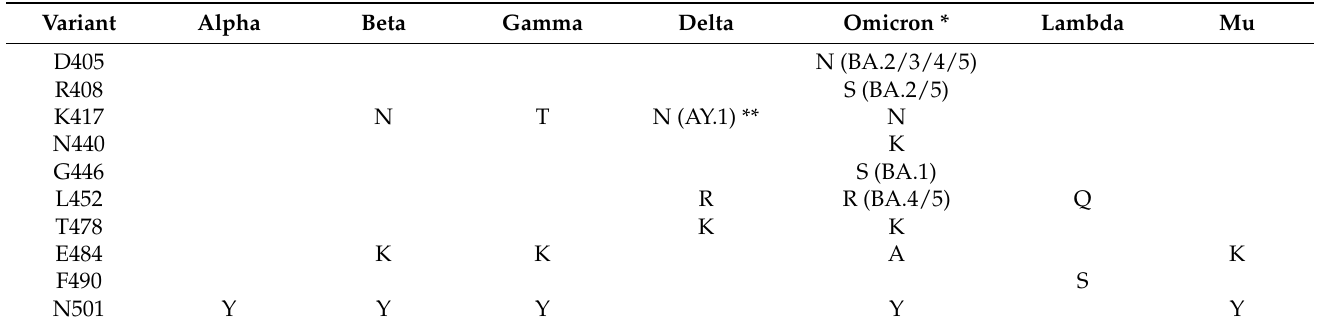
Table 1. Mutations analyzed in Sanger sequencing for variant